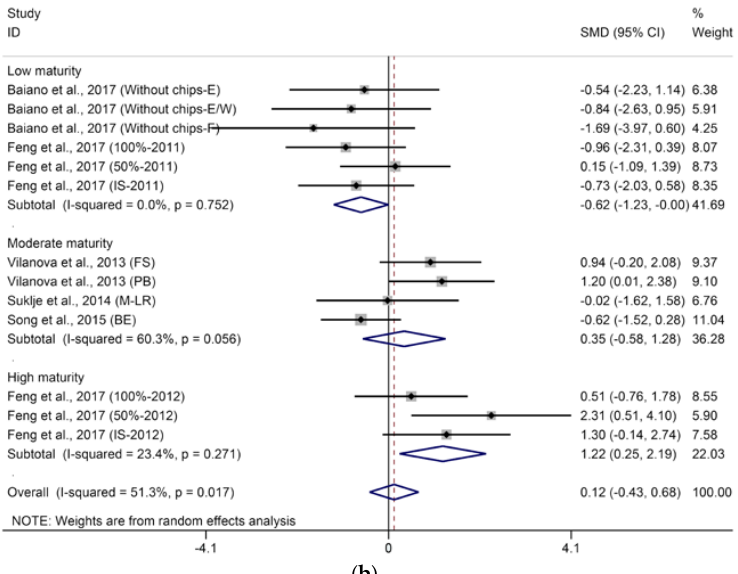
Figure 8. Meta-analysis for the effects of basal defoliation on decanoic acid in wine, of which trials were categorized based on the ( a ) timing of basal defoliation (pre-veraison and veraison/post-veraison) and ( b ) berry maturity level (low maturity of °Brix < 23, moderate maturity of 23 < °Brix < 25, high maturity of °Brix > 25).